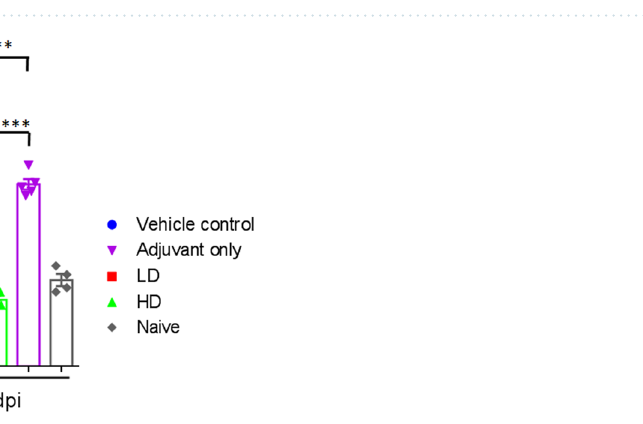
Figure 4. Viral load in hamsters 3 or 6 days post infection with SARS-CoV-2. The hamsters were euthanized at 3 or 6 d.p.i. and lung tissue samples were collected for viral load determination by ( a ). quantitative PCR of viral genome RNA, and ( b ). TCID 50 assay for virus titer. Results are presented as geometric mean with error bars representing 95% confidence interval and statistical significance calculated with Kruskal–Wallis with corrected Dunn’s multiple comparisons test. Dotted lines represent lower and limit of detection (100).